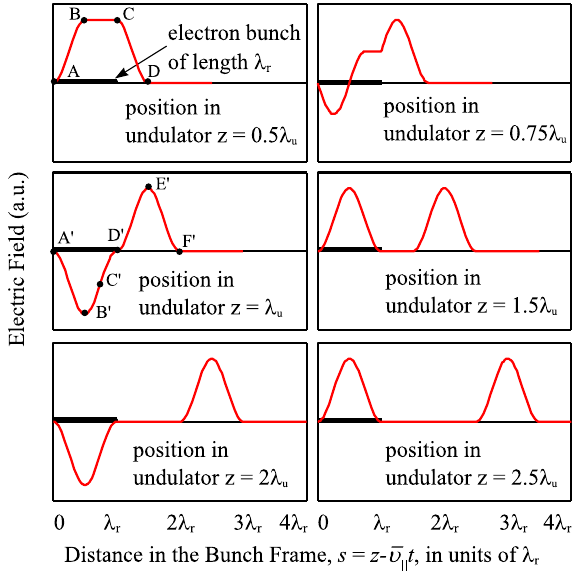
FIG. 2. The electric field created by the uniform electron as a function of distance, s ¼ z (cid:1) (cid:1) v k t , in bunch of length (cid:4) r the frame moving with the bunch. Different cross sections of the undulator are shown. The arrival time of electrons at the obser- vation position in the undulator is shown by the black box lying on the